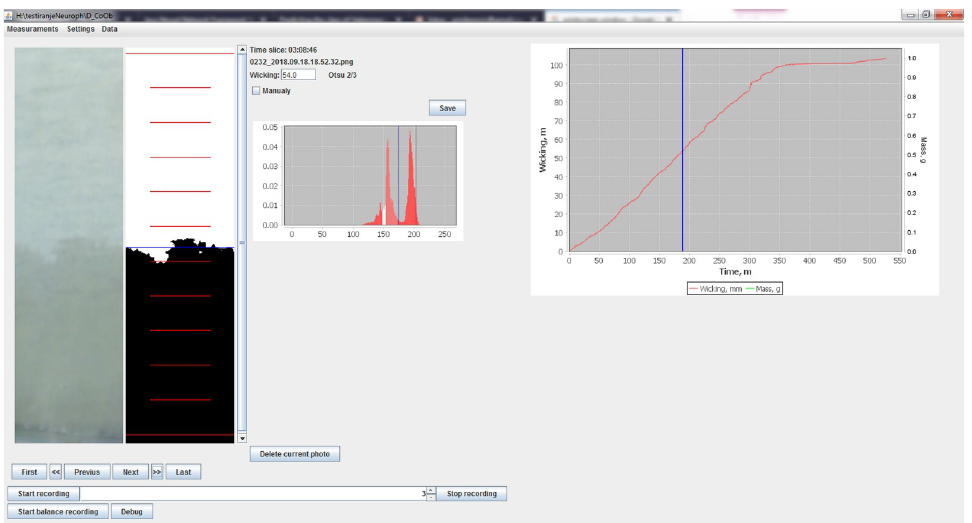
Fig 3. Screenshot recorded during determination of wicking of cotton knitted fabric.